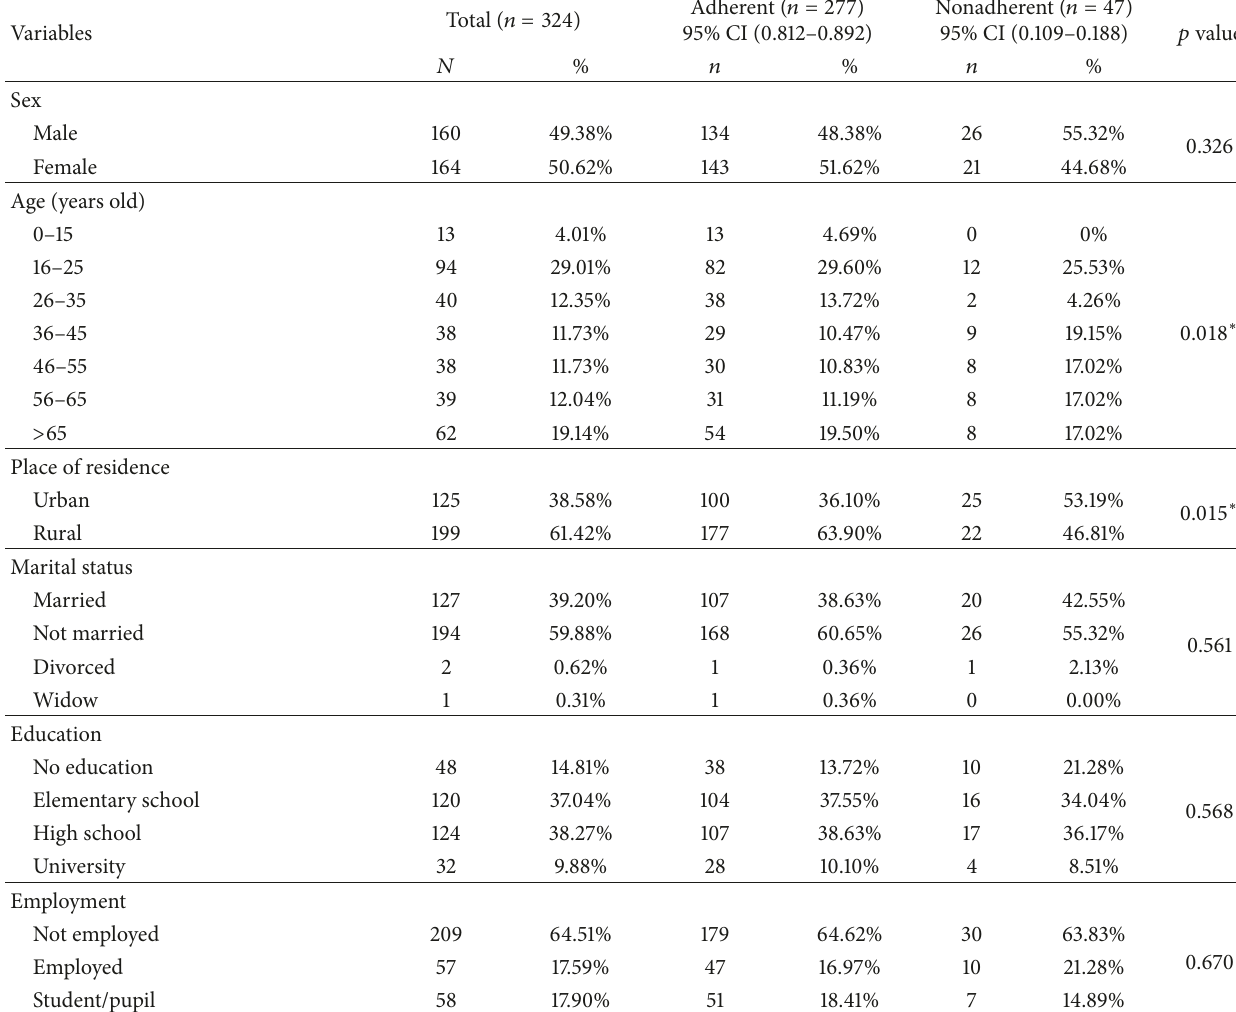
Table 1: Sociodemographic data